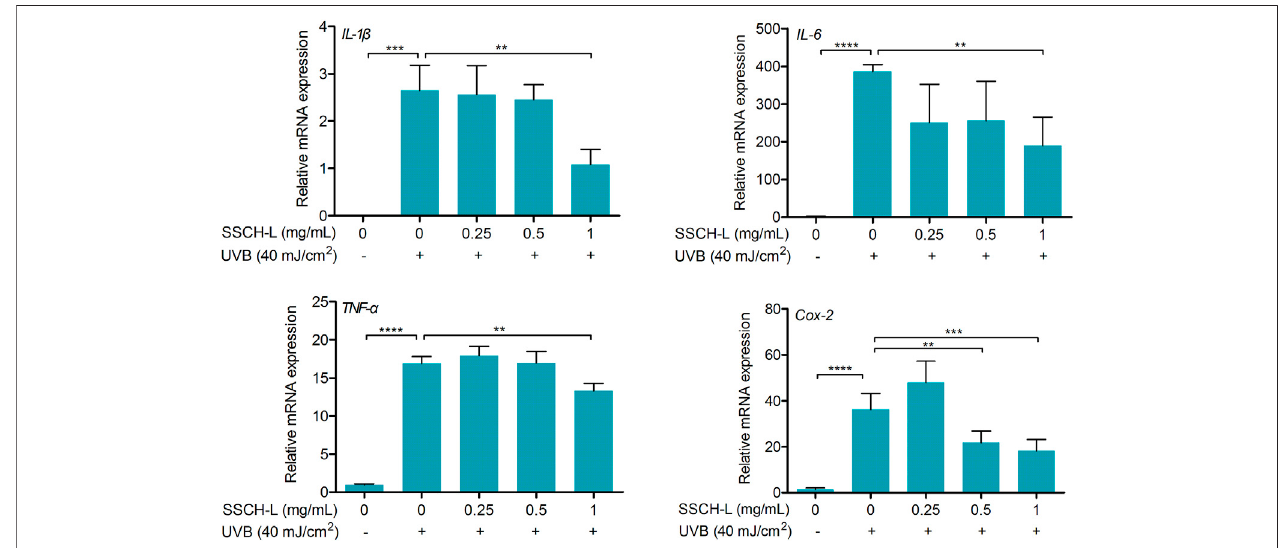
FIGURE 6 | Effect of SSCH-L on the expression of pro-in fl ammation cytokines and Cox-2 in the L929 cells exposed to 40 mJ/cm 2 UVB.